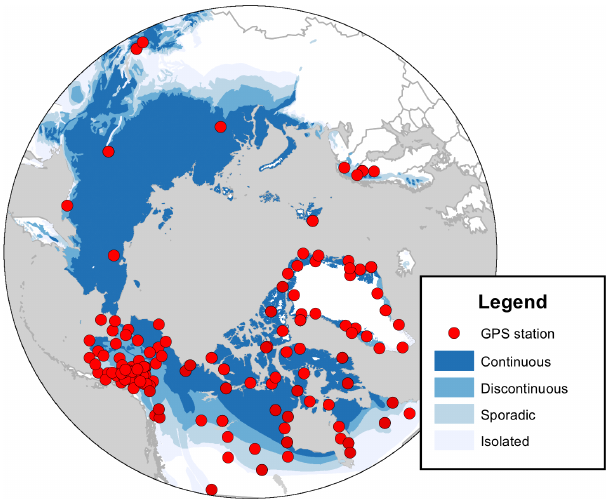
Figure 1. Locations of continuously operating and open-data GPS stations in the permafrost areas north of 50 ◦ N. The permafrost zonation, represented by various colors, is based on Brown et al.